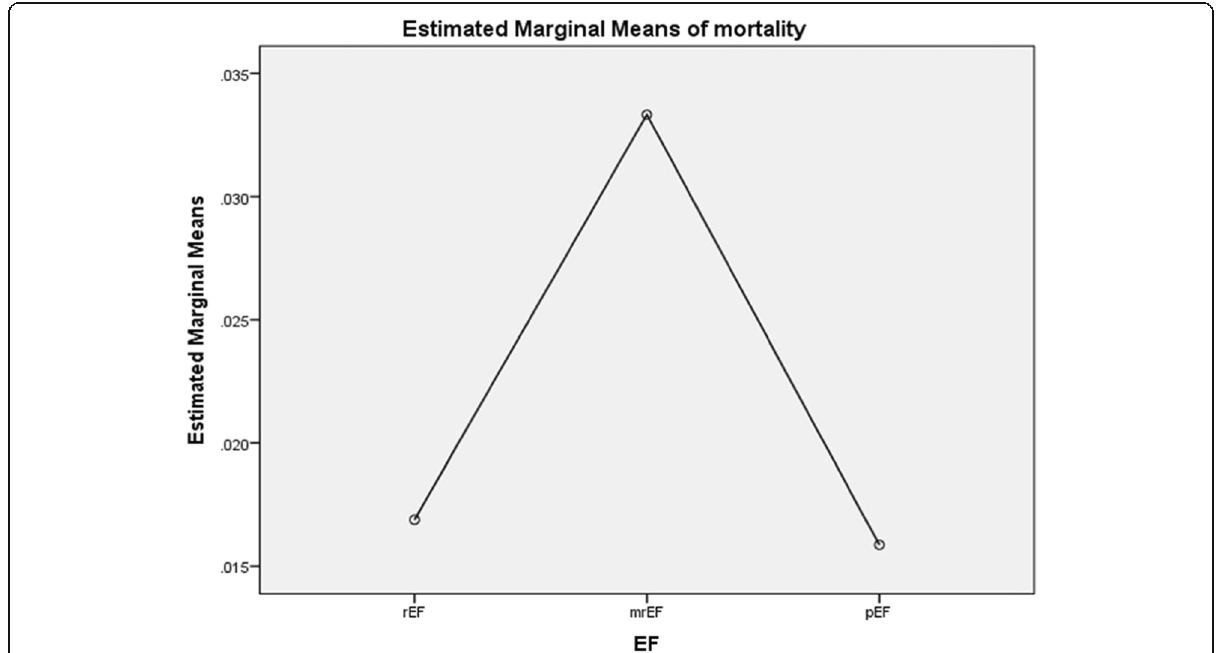
Fig. 2 Univariate analysis for mortality in patients admitted with heart failure. rEF reduced ejection fraction, mrEF mid-range ejection fraction, pEF preserved ejection